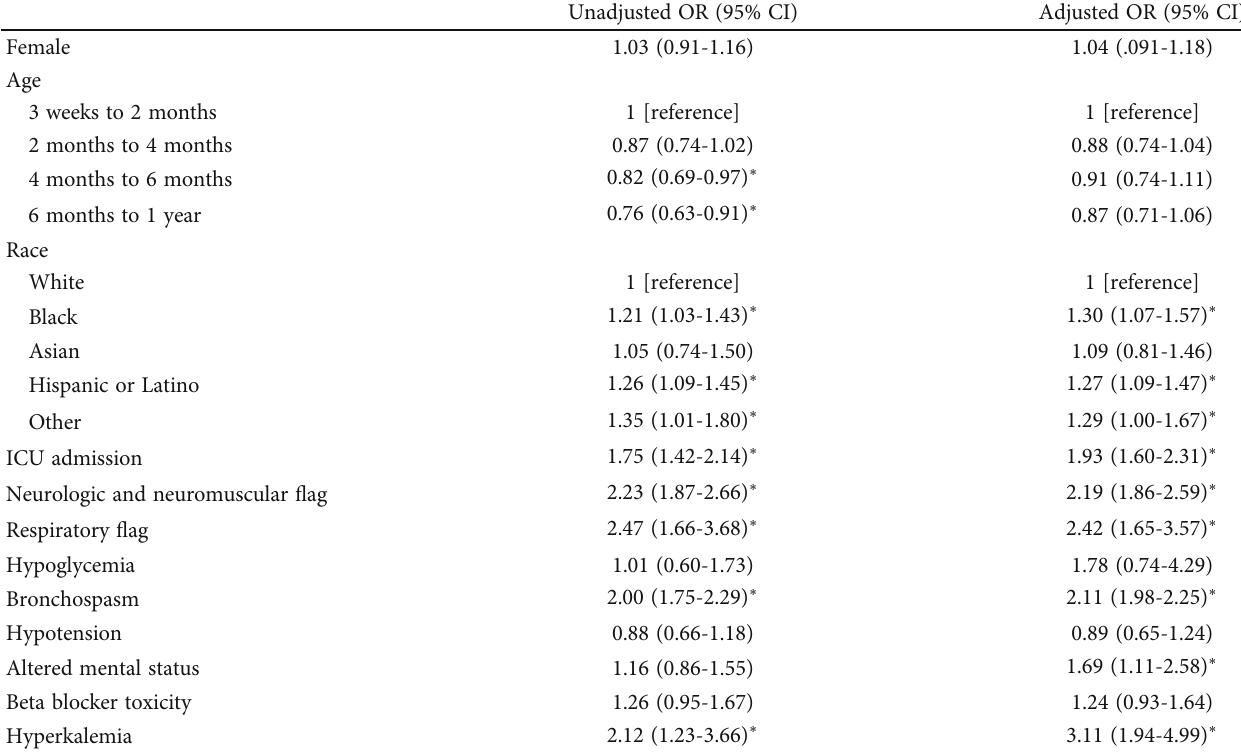
Table 5: Odds ratios for total costs of inpatient infantile hemangioma